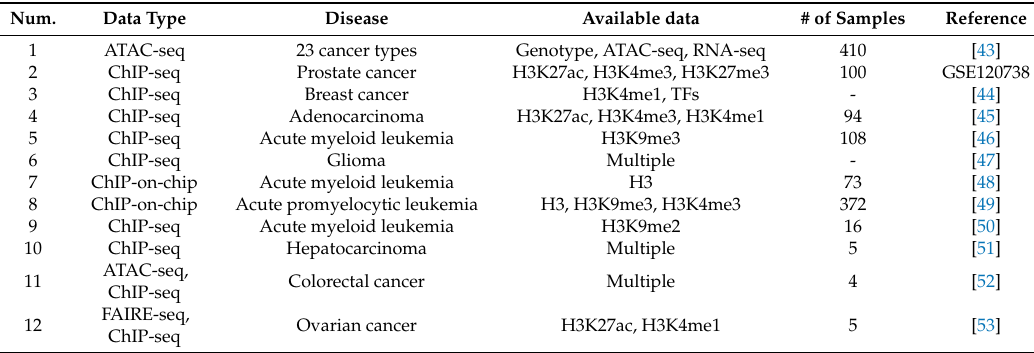
Table 1. A collection of epigenetic studies (excluding DNA methylation) in disease context including the data type, number of samples, disease type, and publication reference.